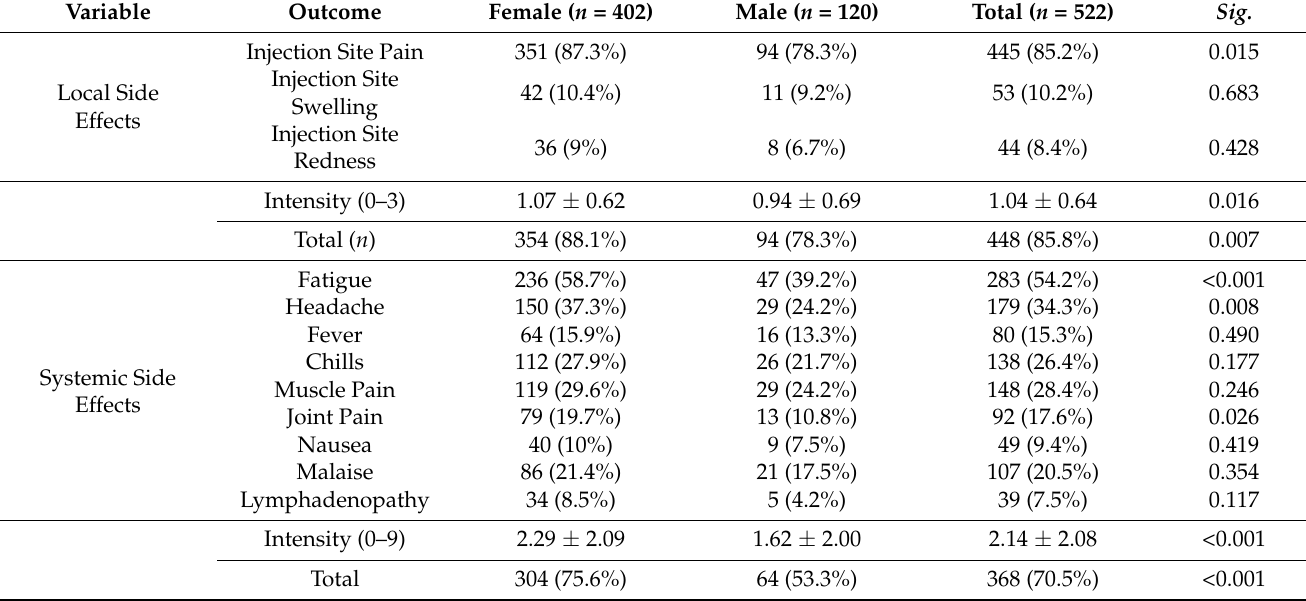
Figure 2. Side effects experienced by Slovak healthcare workers who received BNT162b2 and stratified by gender, February– March 2021 ( n = 522). * Significance level < 0.05. Table 4. Local and systemic side effects of Slovak healthcare workers who received BNT162b2 and stratified by gender, February–March 2021 ( n =